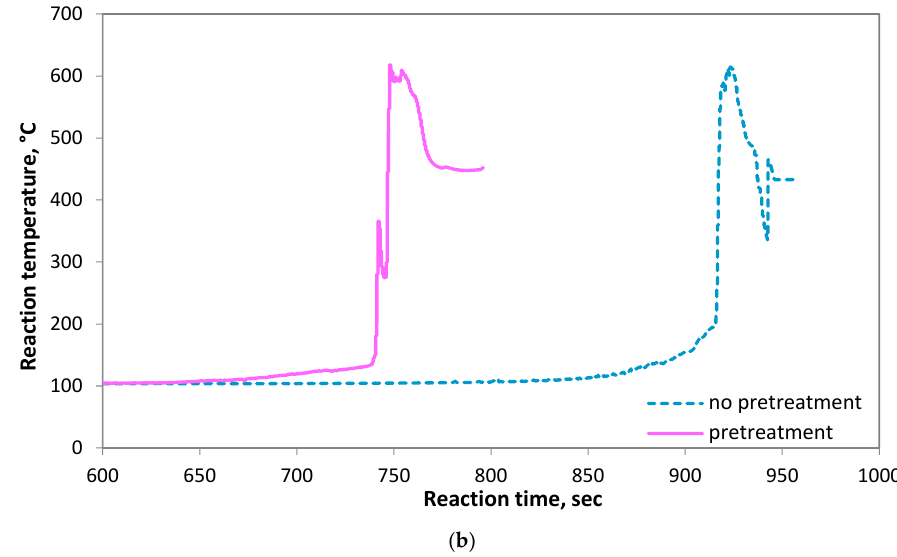
Figure 9. Reaction temperature as a function of reaction time during SCS for the samples with and without pretreatment on the basis of the initial mixture: ( a ) 66.7% Ni(NO 3 ) 2 , 33.3% glycine, and 75 mL H 2 O; and ( b ) 66.7% Ni(NO 3 ) 2 , 33.3% glycine, and 100 mL H 2 O.